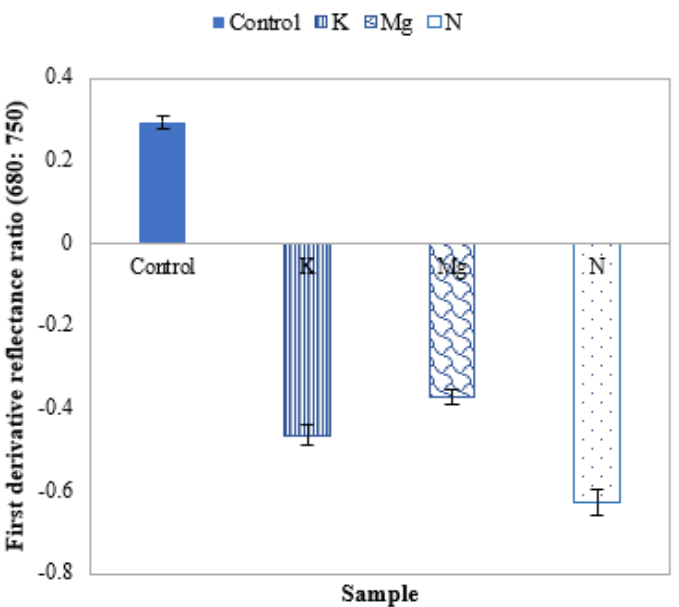
Figure 9. A plot of the mean first derivative reflectance ratio of control and different nutrient-deficient leaves, representing the difference between control and nutrient-deficient leaves.